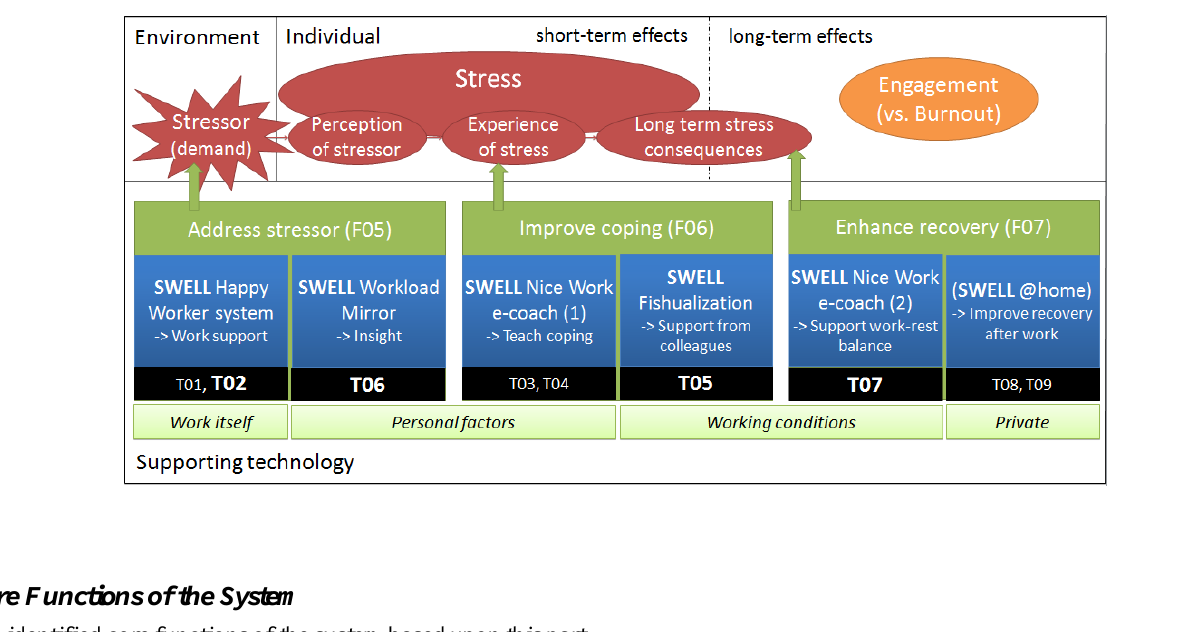
Figure 10. SWELL system functionality in our general